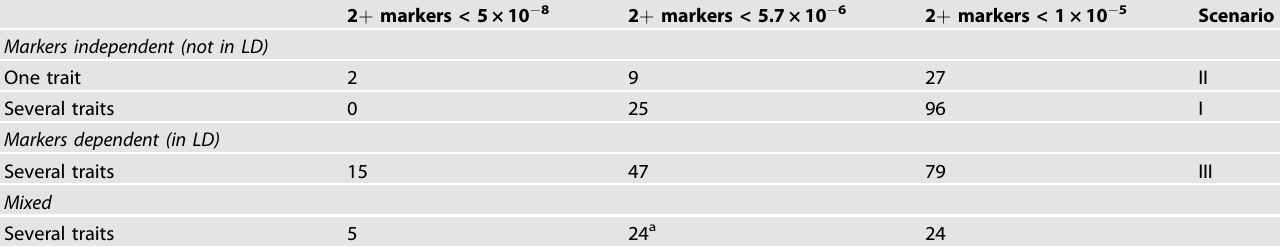
Table 1. Number of gene/gene-groups containing more than one marker associated after cojo-GCTA at different signi fi cance threshold